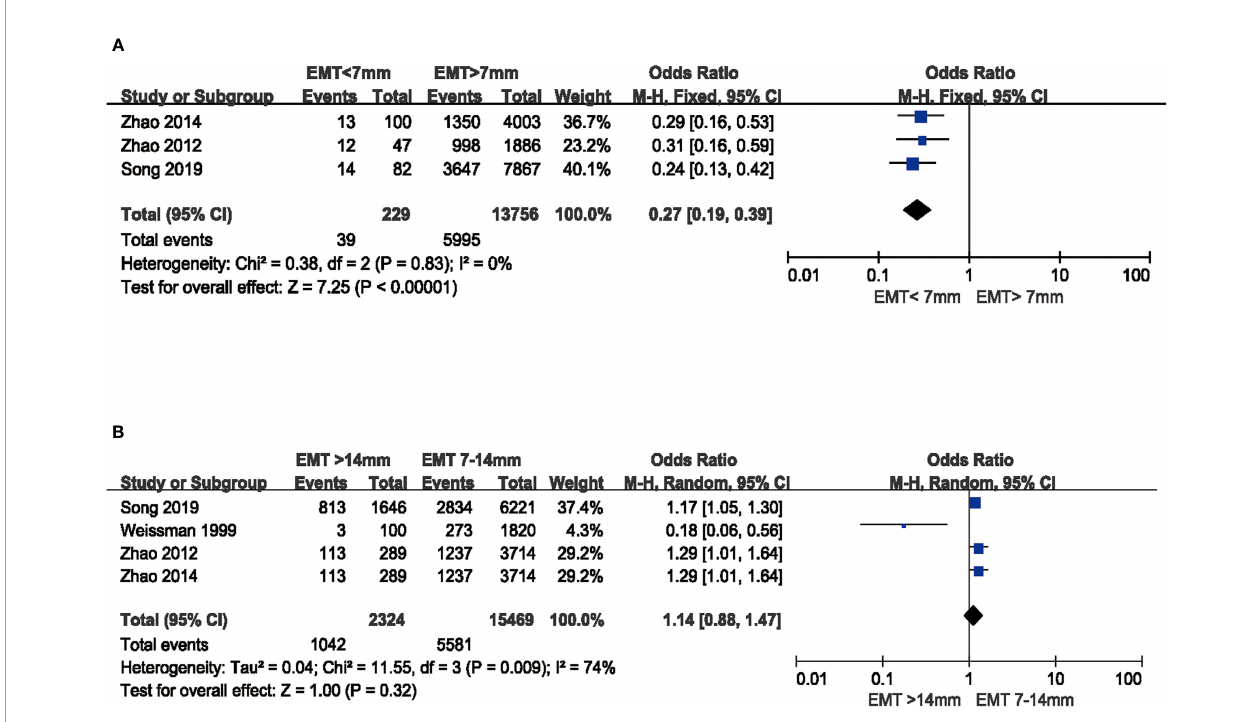
FIGURE 4 | Comparison of IR between EMT groups in fresh cycles. (A) Comparison between thin endometrium group and non-thin endometrium group. (B) Comparison between thick endometrium group and medium endometrium. IR, Implantation